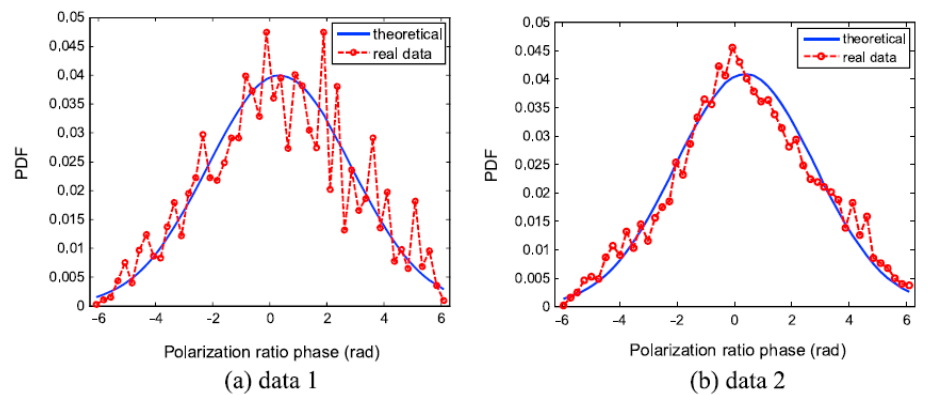
Fig. 7 Simulation results of lognormal distribution clutter